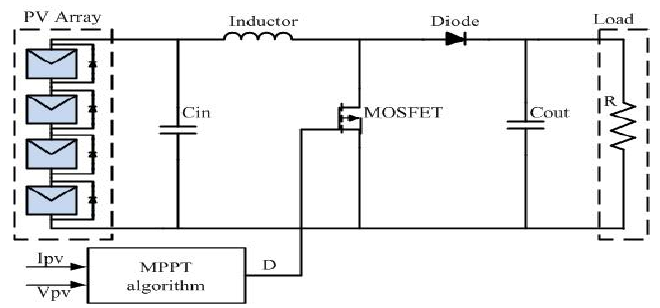
Figure 1. Standalone PV system with boost converter and MPPT controller.